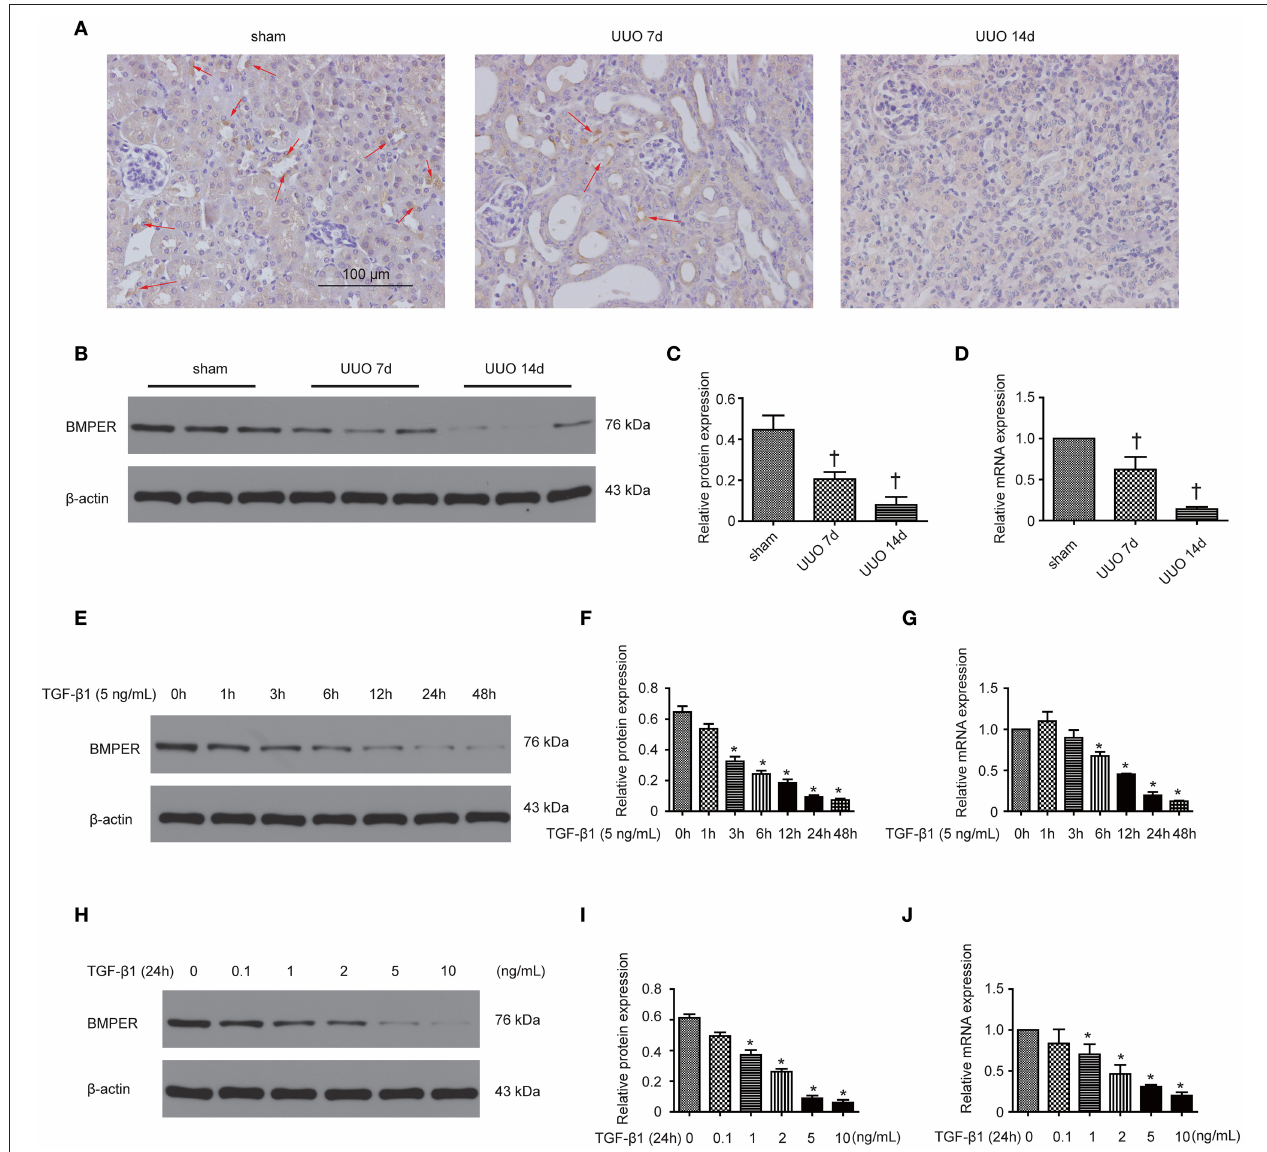
FIGURE 1 | BMPER expression decreased in kidneys after UUO and in HK-2 cells exposed to TGF- β 1. Kidneys with indicated UUO time and sham controls were subjected to immunohistochemical staining for BMPER (A) . Arrows indicated BMPER-positive tubular cells. Scale bar = 100 µ m. BMPER expression in kidneys was measured by Western blot (B) . The relative protein expression for BMPER in kidneys was displayed (C) . The mRNA expression of BMPER in kidneys with sham operation and UUO was shown (D) . Values are the means ± SEM ( n = 6). HK-2 cells were exposed to TGF- β 1 at indicated time and BMPER expression was measured by Western blot (E) . The relative protein expression for BMPER in HK-2 cells was displayed (F) . The mRNA expression of BMPER in HK-2 cells was shown (G) . HK-2 cells were exposed to TGF- β 1 at various concentration and BMPER expression was measured by Western blot (H) . The relative protein expression for BMPER in HK-2 cells was displayed (I) . The mRNA expression of BMPER in HK-2 cells was shown (J) . Values are the means ± SEM ( n = 3). † p < 0.05 vs. sham; * p < 0.05 vs.